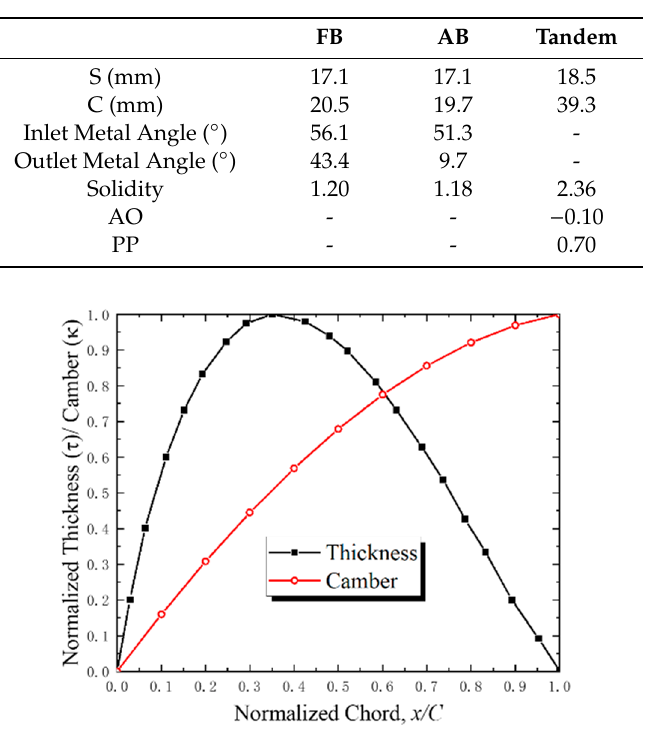
Table 1. Tandem airfoil geometric parameters.